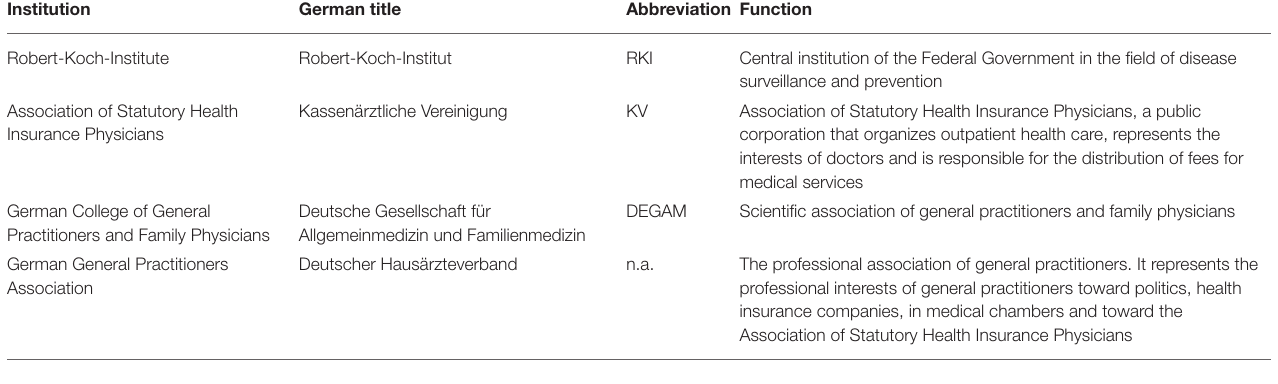
TABLE 3 | Information on the German institutions mentioned in the quotations. Institution